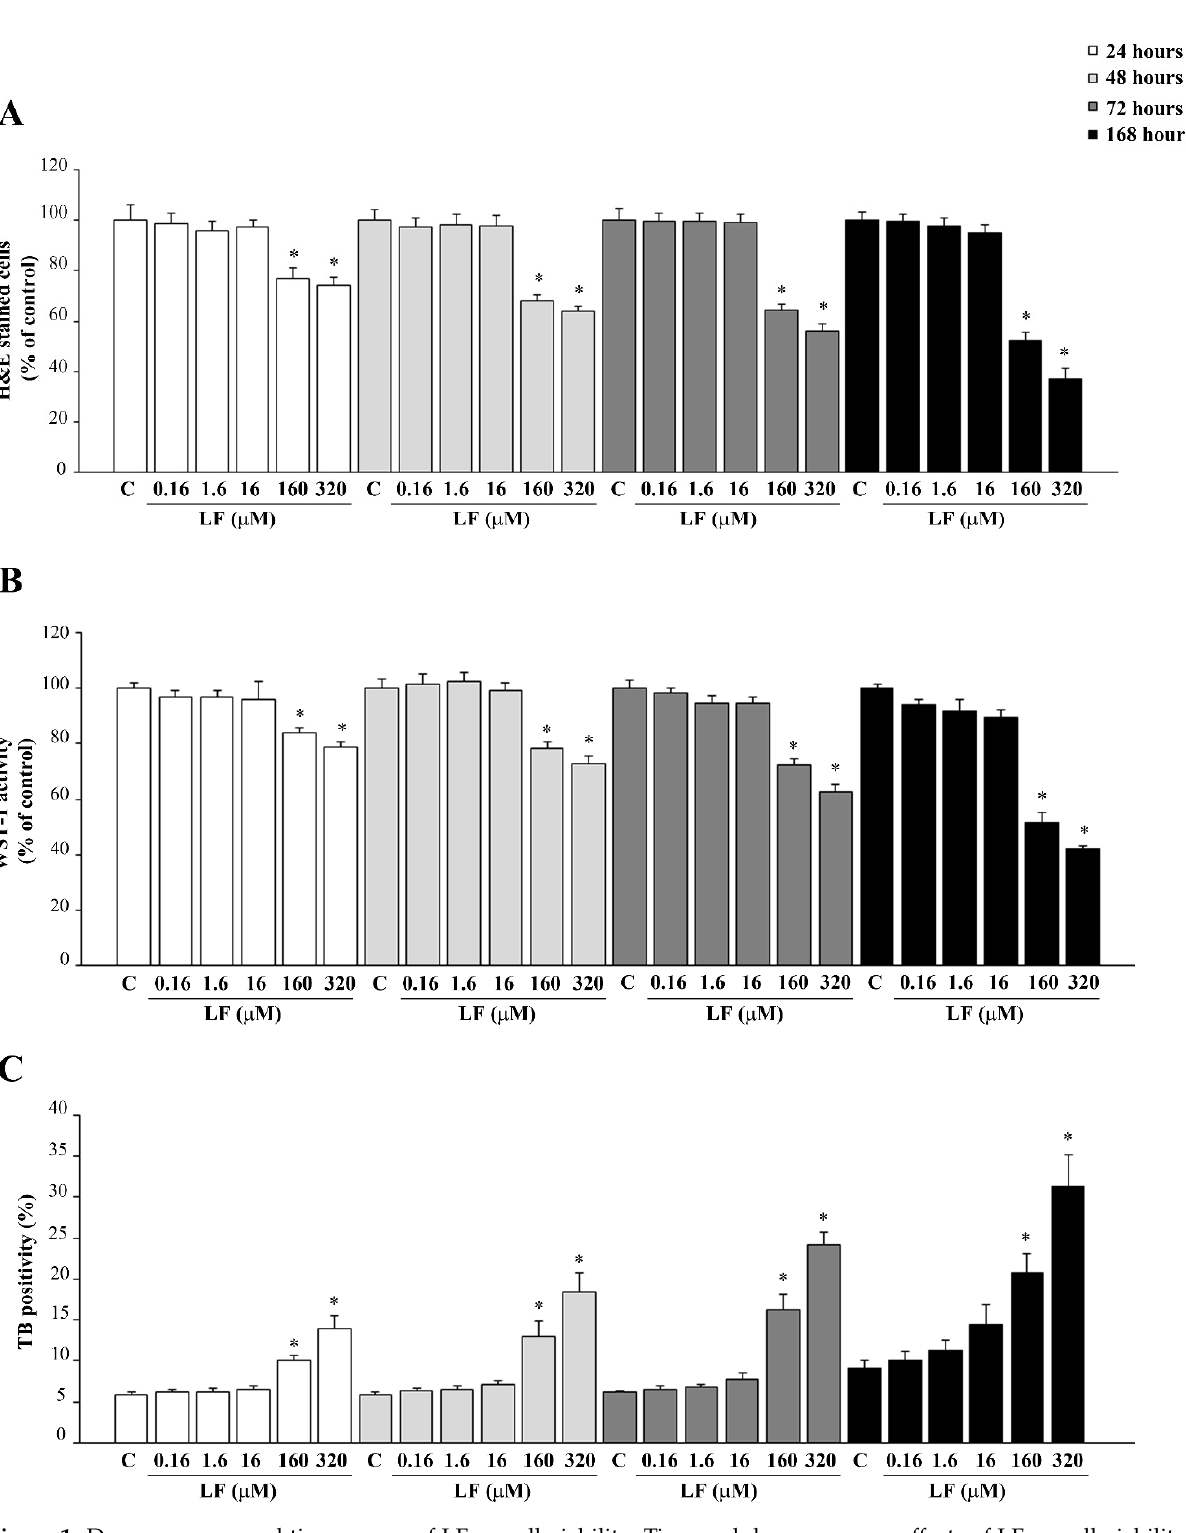
Figure 1. Dose–response and time-course of LF on cell viability. Time and dose–response effects of LF on cell viability; ( A ) H&E, ( B ) WST-1 assay, and ( C ) TB staining. C (control) refers to untreated P12 cells. * p < 0.05 compared with control.